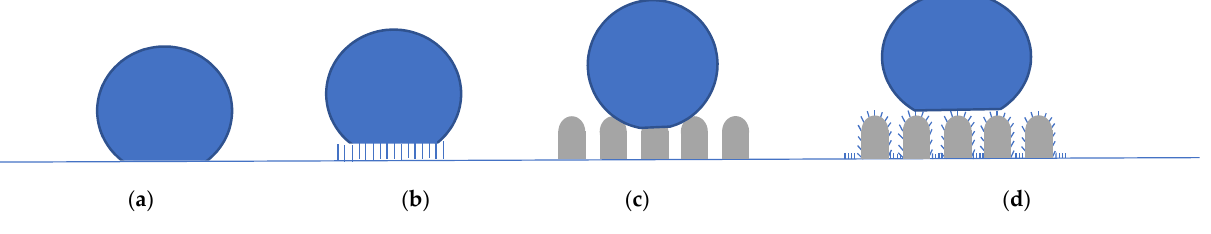
Figure 1. Schematic arrangement of a water droplet on ( a ) smooth and non-modified surface, ( b ) smooth and laser-modified surface, ( c ) surface geometrised during production, ( d ) hierarchic structure formed during laser modification.